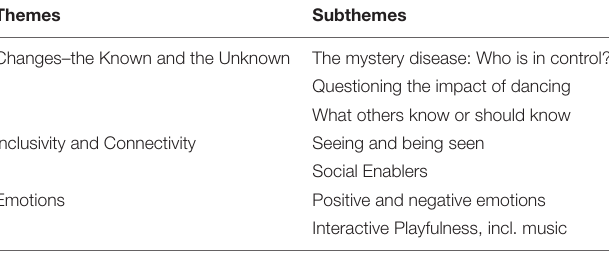
TABLE 2 | Themes from the interviews with people with Parkinson’s.